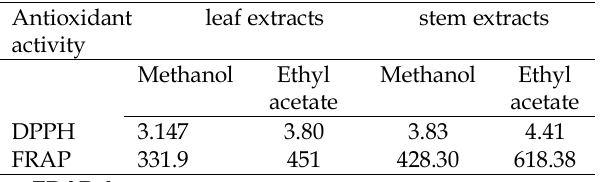
Table 5 : IC 50 in μg/ml for antioxidant activity of Bryophyllum pinnatum extracts. IC 50 for vitamin C in DPPH is 2.39, while that for FRAP is 220.24